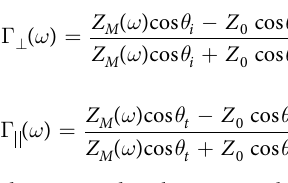
where θ i and θ t are incidence angle and transmitted angle, respectively. Figure 8(c) and (d) show the absorptivity at different incident angles ( θ ) for the TE mode from 0°–30°. When PIN the diode is in the ON state, the absorptivity remains the same up to 20°. However, when the incident angle is 30°, the absorbing bandwidth is blue shifted around 0.5 GHz. Even when the PIN diode is in the OFF state, it